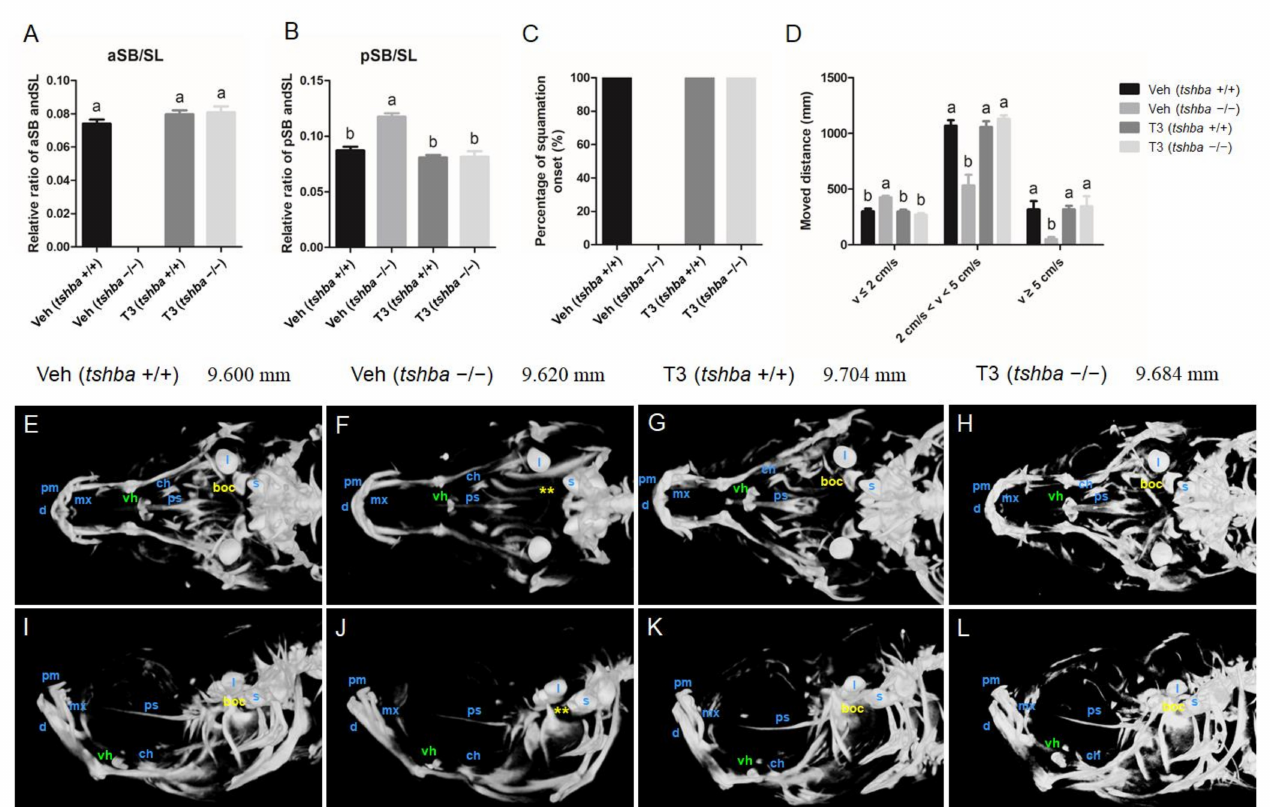
Figure 4. Larval-to-juvenile transition defects rescued by supplemental T3 treatments in tshba mutant zebrafish. ( A ) Relative ratios of the relative length of the aSB to the standard length (SL) of the zebrafish body at 20 dpf. ( B ) Relative ratios of the relative length of the posterior swim bladder (pSB) to the SL of zebrafish body at 20 dpf. ( C ) Percent onset of squamation in zebrafish at 32 dpf. ( D ) The locomotive activity of zebrafish at 30 dpf. The x-axes show the movement velocity. The swimming ability of zebrafish is shown by the moving distance with low velocity (v ≤ 2 cm/s), medium velocity (2 cm/s < v < 5 cm/s), and high velocity (v ≥ 5 cm/s). ( E – H ) Micro-CT scan of the craniofacial skeleton in zebrafish at 30 dpf. Dorsal view. ( I – L ) Micro-CT scan of the craniofacial skeleton in zebrafish at 30 dpf. Lateral view. Images not to scale. The SL of each zebrafish is presented above the panels. The basioccipital bones are labeled in yellow. The ventral hypohyals are labeled in green. Yellow asterisks indicate the bony process on the basioccipital, which did not appear in control tshba mutant zebrafish. Abbreviations: boc, basioccipital; d, dentary; l, lapillus; mx, maxilla; pm, premaxilla; ps, parasphenoid; vh, ventral hypohyals; s, sagitta. a–b, different superscripts in the same column indicate significant differences ( p <